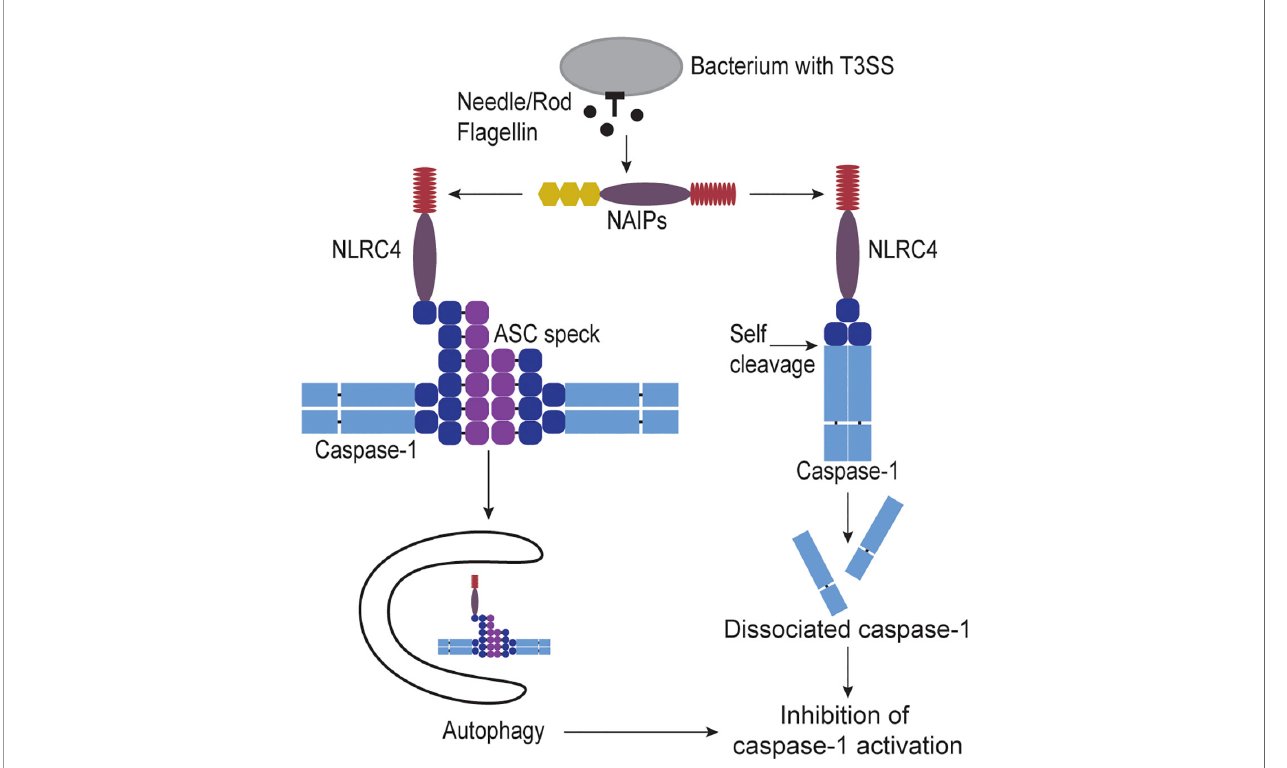
FIGURE 2 | Regulation of caspase-1 activity. When cytosolic invasive bacteria accidently secrete fl agellin, T3SS rod, or T3SS needle proteins they are detected by NAIPs. NAIPs activate NLRC4 which in turn recruits and activates caspase-1. Once caspase-1 is activated it can activate gasdermin D to form pores in the plasma membrane causing cell swelling and lysis called pyroptosis. However, caspase-1 has two mechanisms for inactivation. One way to inhibit caspase-1 is through sequestration of caspase-1 from the cytosol by capturing it in autophagosomes. NLRC4 has been shown to activate the autophagy pathway. NLRC4 also can recruit the adaptor protein ASC speck which can bind multiple capase-1 proteins. This ASC speck is large enough that the autophagy pathway can recognize and engulf the protein complex, therefore capturing the bound caspase-1 as well. Another way to inhibit caspase-1 is through self-cleavage by caspase-1 itself. NLRC4 or ASC directly bind caspase-1, bringing the proteins close enough to dimerize. Caspase-1 can then directly cleave between its CARD and protease domains. This cleavage releases the protease from the activating platform, allowing the caspase protease domains to disassociate, rendering caspase-1